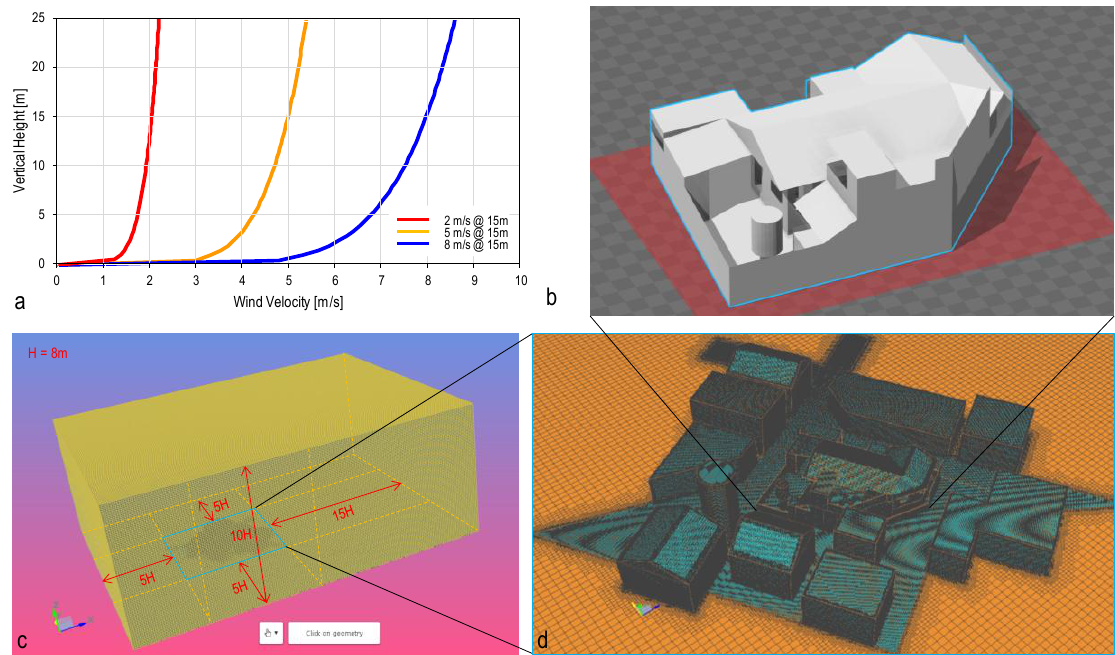
Figure 4. Modeling and meshing of the detached family house together with the neighborhood: ( a ) wind velocity at different heights; ( b ) walled detached family house; ( c ) modeled house with neighborhood in computational domain, and; ( d ) mesh of modeled house with neighborhood.